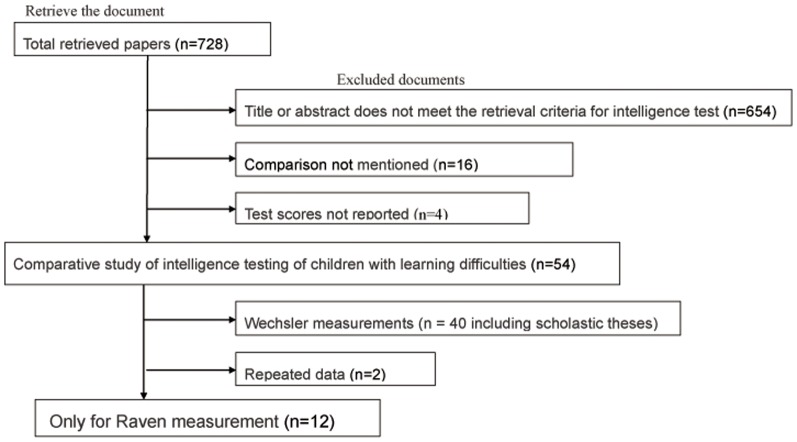
Flowchart of document retrieval.